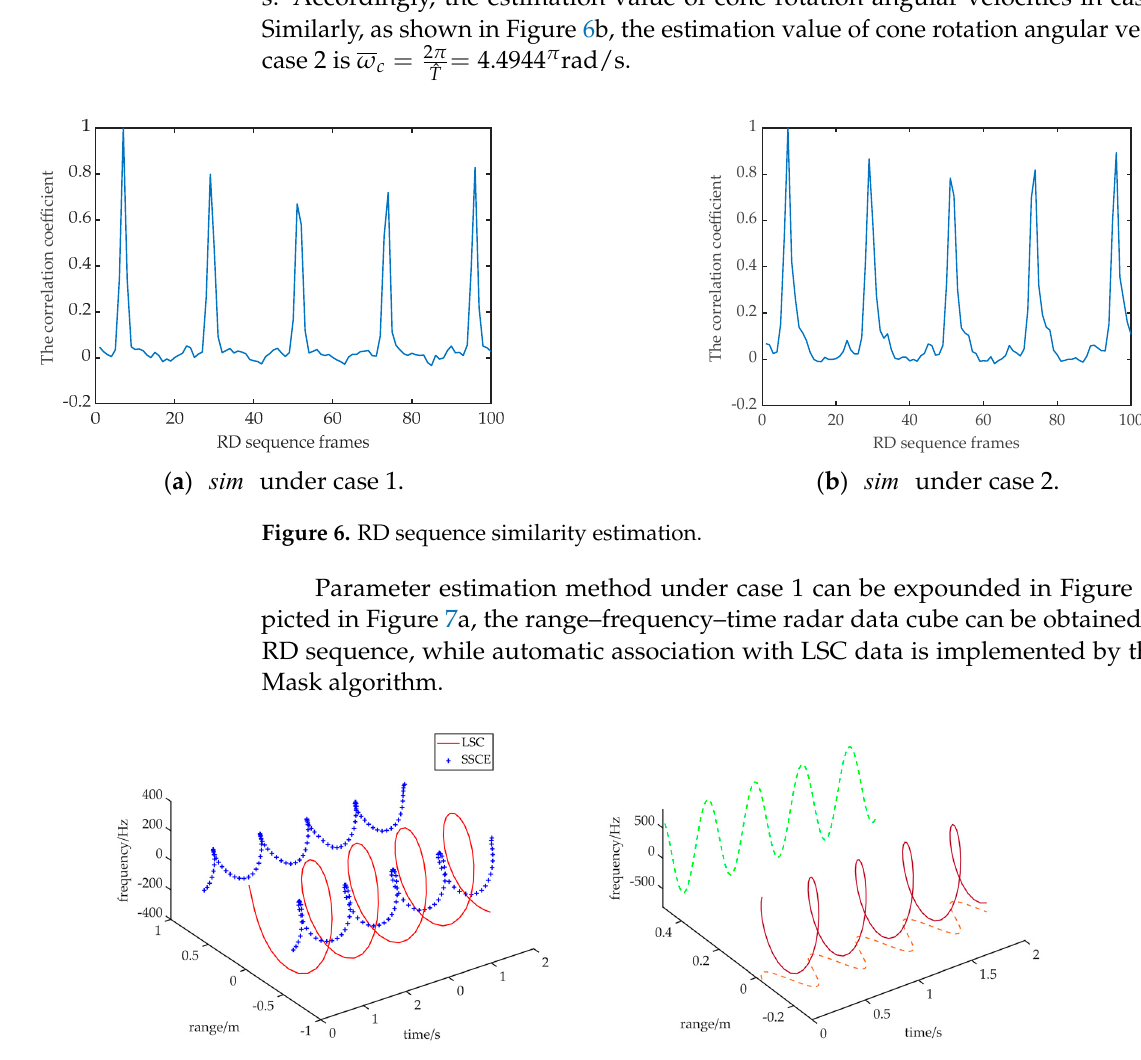
Figure 7. Parameter estimation method under case 1.